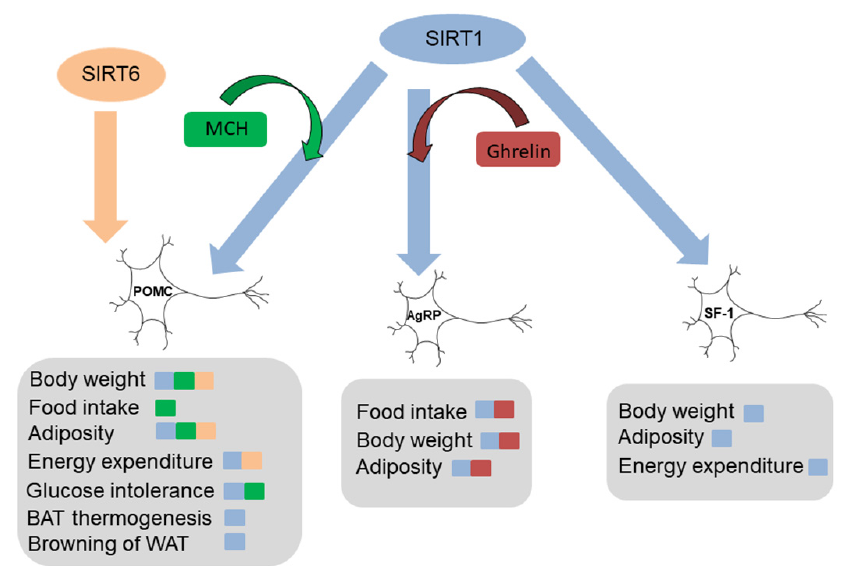
Figure 2. SIRT1 and SIRT6 in hypothalamic neurons: The effects of SIRT1 and SIRT6 in the hypothalamus may depend on the neuronal type. Abbreviations used-AgRP: Agouti-related protein neurons; BAT; brown adipose tissue; MCH: melanin concentrating hormone; POMC: Proopiomelanocortin neurons; SF-1: steroidogenic factor 1; WAT; white adipose tissue. The figures were generated by using materials from Servier Medical Art (Servier) under consideration of a Creative Commons Attribution 3.0 Unported